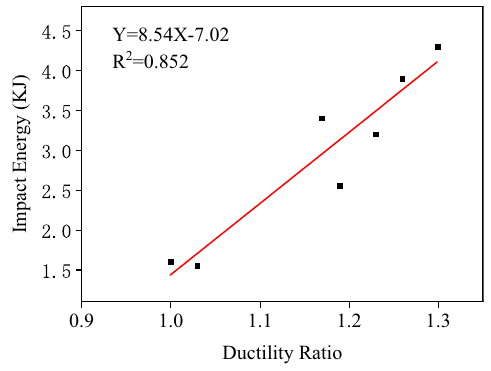
Figure 11: Impact failure patterns of nano - concrete specimens: ( a ) specimen without SF and ( a ) specimen with 1.5% SF. Figure 12: Correlation between impact energy and ductility